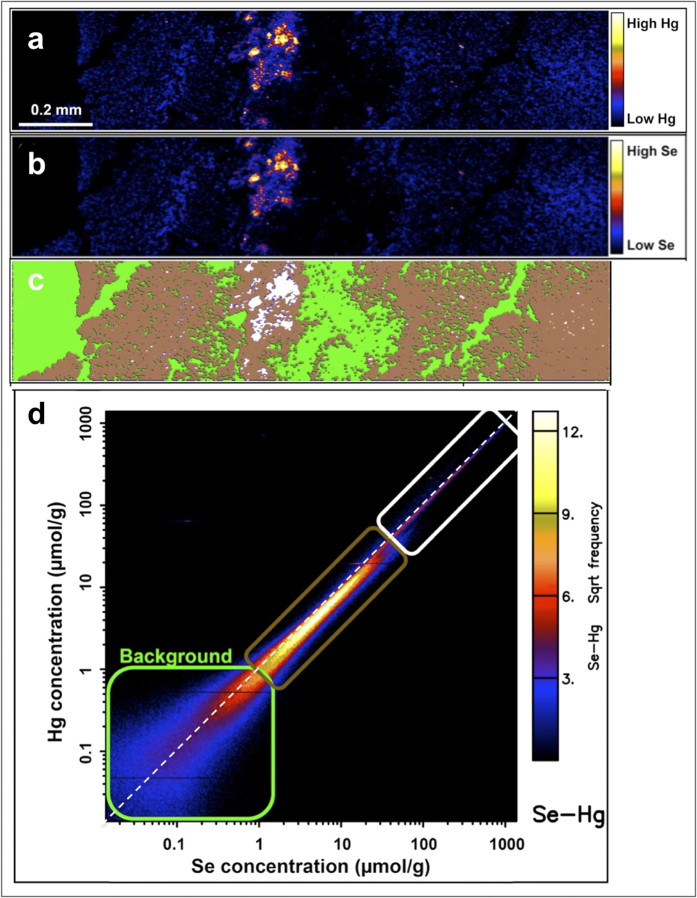
Interaction of Hg and Se of Se-Hg clusters.2D map of Hg (a) and Se (b) distribution in the liver of an adult whale generated by synchrotron μ-XRF from a 30 μm thin section. Hg clusters are visible in the areas of high Hg intensity (yellow/white), which corresponds with Se distribution. Diffused Hg and Se is illustrated in blue. In c the elemental map of Hg from (a) is overlaid with the three pixel populations identified using the ‘elemental association’ module in GeoPIXE, with each pixel population corresponding to the coloured boxes in the element correlation plot in (d). Se:Hg molar ratio of 1 is highlighted in (d) by a diagonal white dashed line. The white rectangle is corresponding to white pixels in the map (c), the aggregates in the map (a) with Se:Hg molar ratio of 1. Areas of low Hg concentration (blue in map (a), represented in brown in map (c) show skewed elemental association towards higher Se in the plot (d) with Se:Hg molar ratio >1.